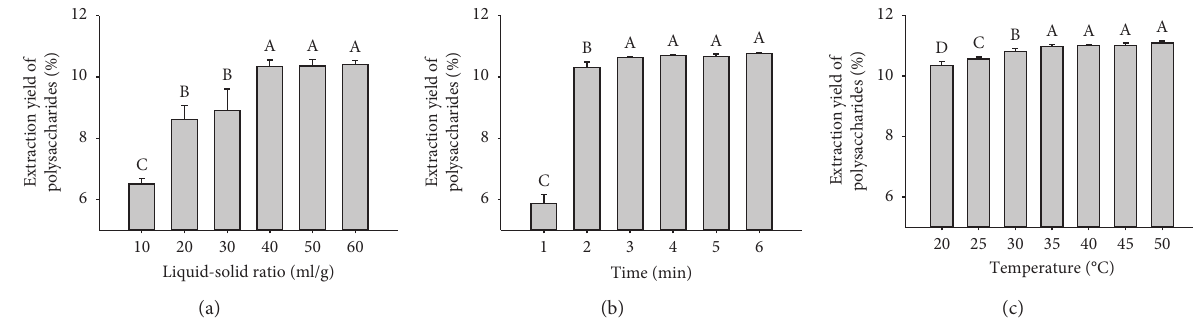
Figure 1: The effects of (a) liquid-solid ratio (mL/g), (b) extraction time (min), and (c) extraction temperature ( o C) on the polysaccharide yield in the PNMP extracts using homogenate extraction method. The different letters (A, B, C, and D) in each graph indicate significant difference ( p < 0 . 05). Table 2: Statistical summary of the surface response analysis. Source Sum of squares Mean square F